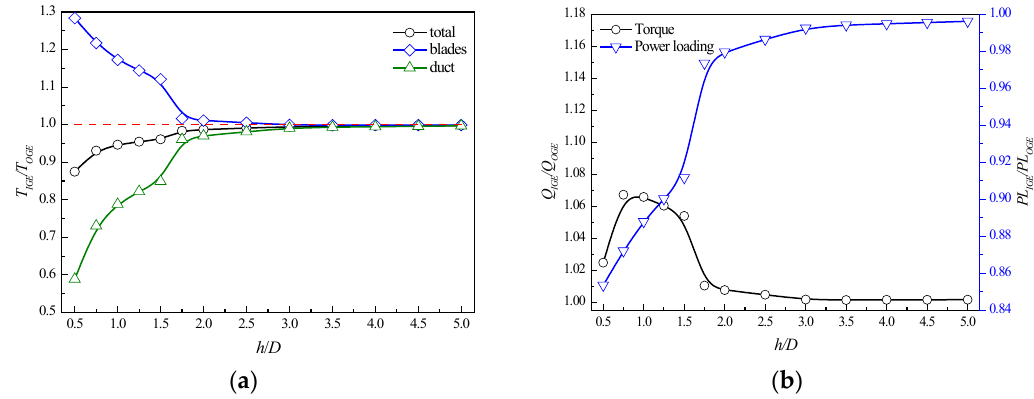
Table 5. Aerodynamic performance of ducted fan when hovering out of ground effect.